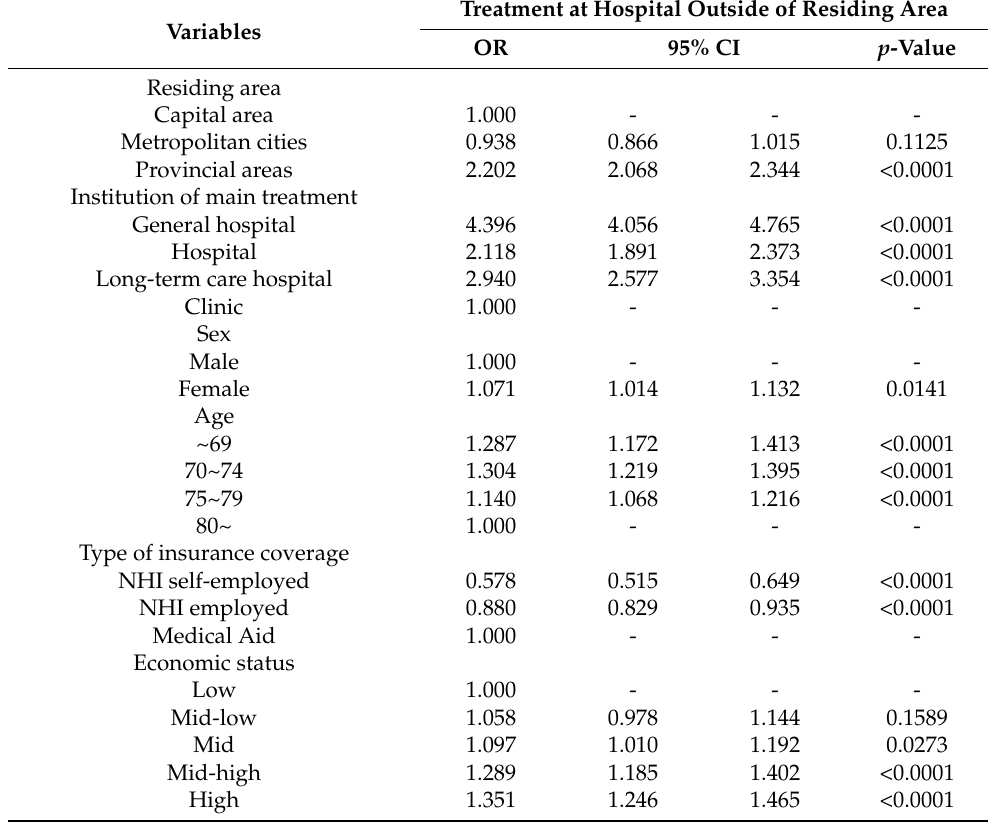
Table 2. Association between area of residence and location of hospital visited for